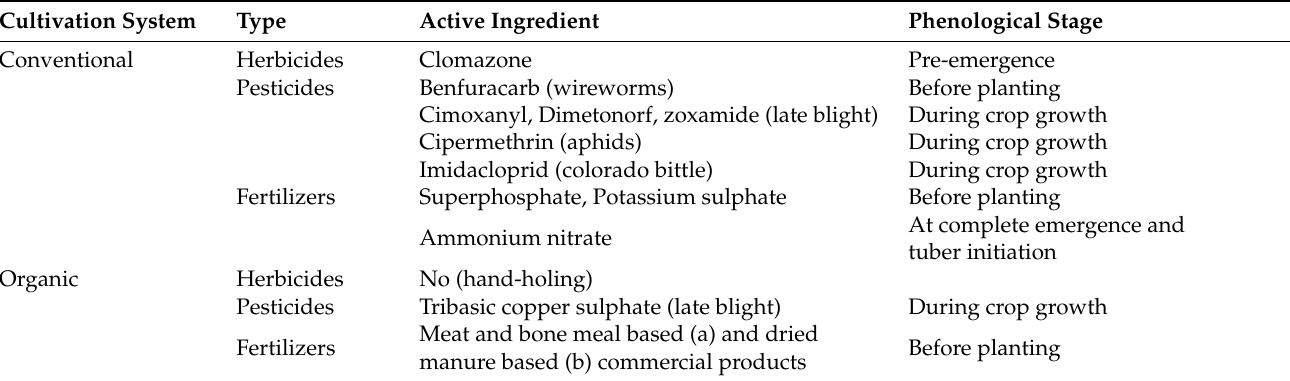
Table 2. Crop management of the two cultivation systems under